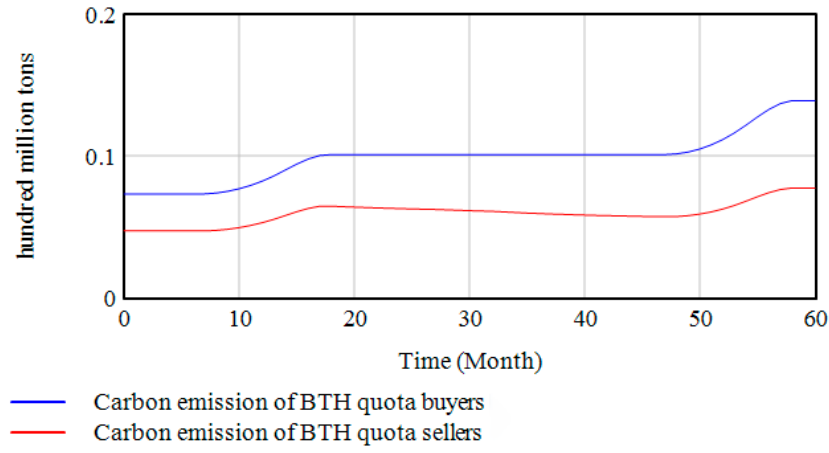
Figure 9. Trend of change in carbon emissions.